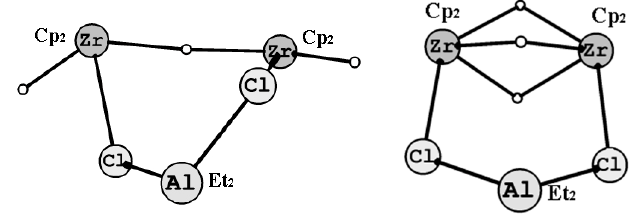
Figure 3. Optimized structures of isomers 9a and 9c .